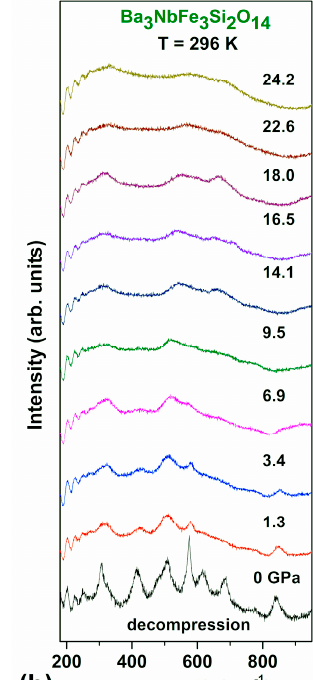
Figure 5. (Colour online) Pressure behavior of Raman peak positions in Ba 3 NbFe 3 Si 2 O 14 at compression ( a ) and decompression ( b ). Dashed lines correspond to the structural transitions observed in XRD and Mössbauer experiments. Solid lines are guides to the eye.